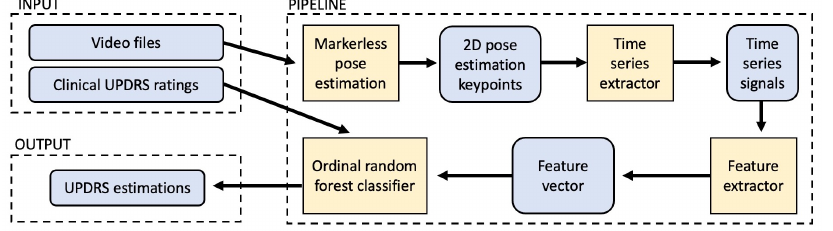
Figure 1. An overview of the pipeline used for this study, which included markerless pose estimation, signal estimation, feature extraction and